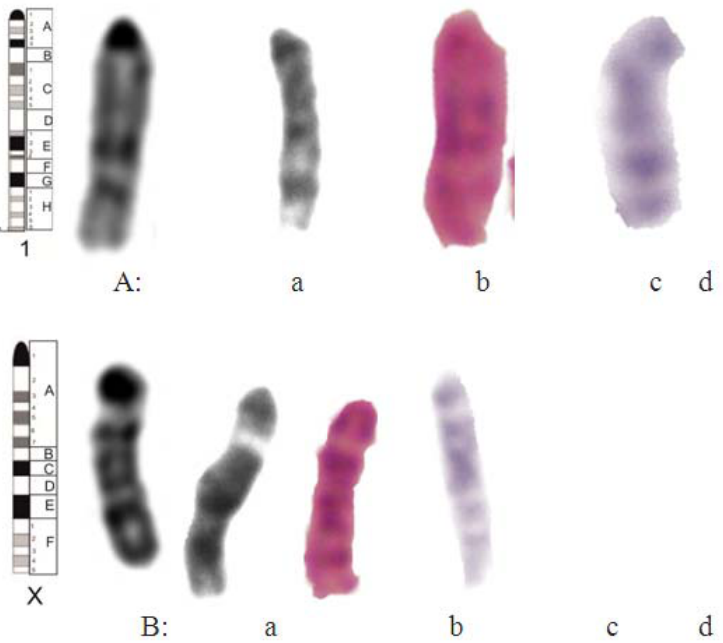
F IGURE 4. (A) G-banded chromosome 1 of the Iranian house mouse with comparative cytogenetic map between the specimens from a. Mashhad ( Mus musculus musculus ), b. Zabol (